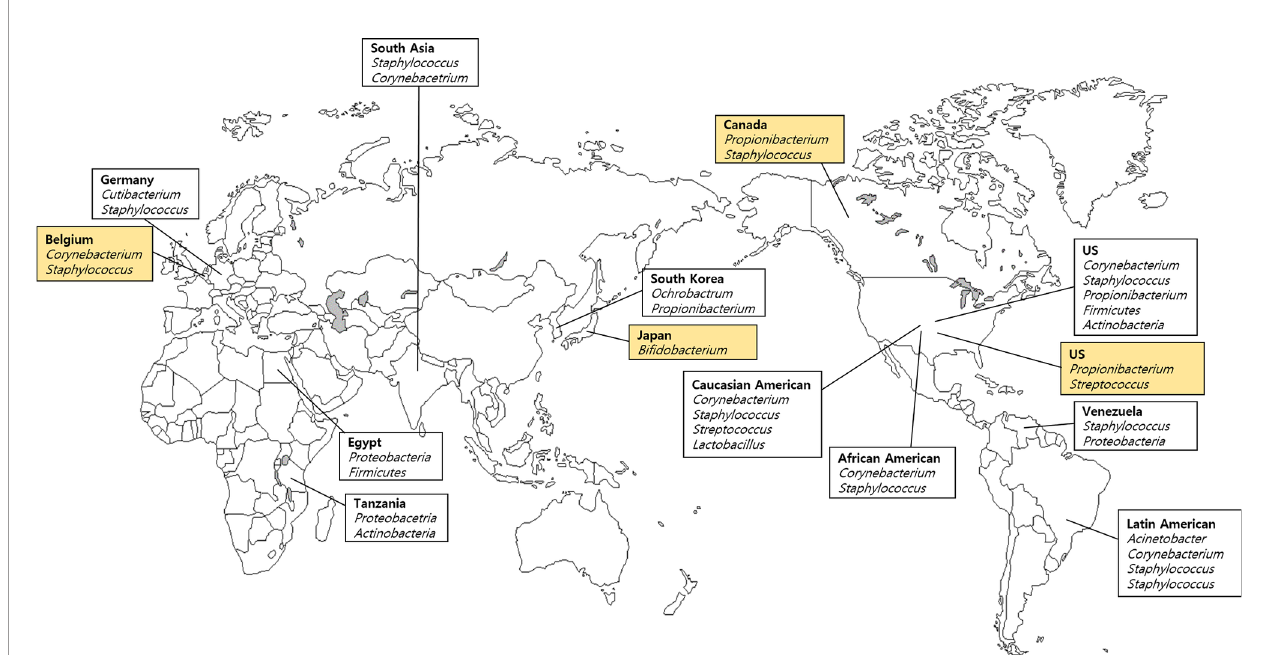
FIGURE 1 | Geographical variation of skin bacteria based on the Forensic Microbiome Database (FMD) (www.fmd.jcvi.org) data and non-FMD. The yellow-colored box is from the FMD data, and only bacteria which account for over 10% are shown. Four countries from the FMD and 10 results from previous studies were included, and the microbiome pro fi ling was generated using 16S rRNA gene sequencing.